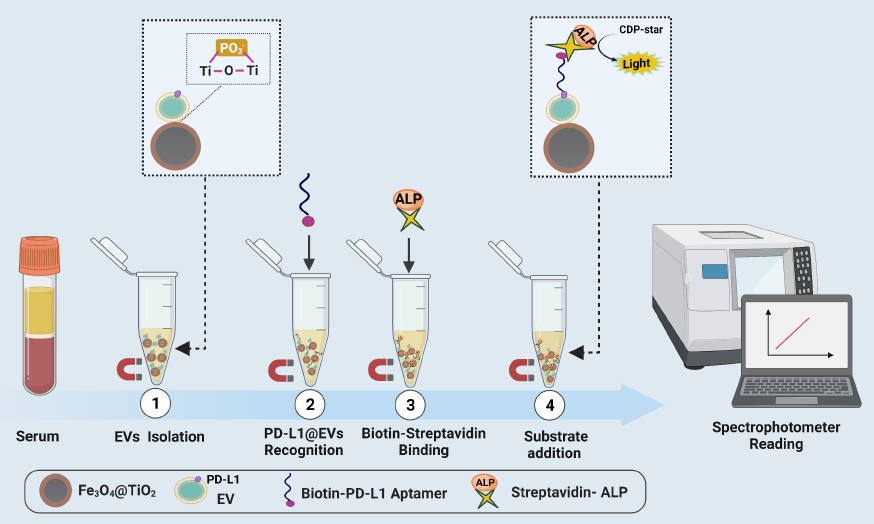
Figure 1. Principal design of the assay. ( 1 ) Fe 3 O 4 @TiO 2 based enrichment of EVs from undiluted serum. ( 2 ) Addition of Biotin-PD-L1 Aptamer to bind to PD-L1@EVs. ( 3 ) Addition of Streptavidin- Alakaline phosphatase (ALP) to achieve Biotin-Streptavidin binding. ( 4 ) Addition of CDP-Star for catalysis by ALP and subsequent reading of chemiluminescense by